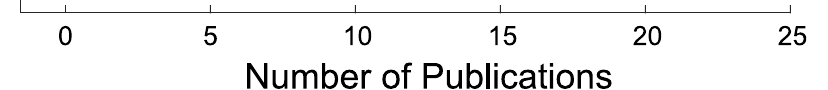
Fig 4. Footwear feature importance and the number of related publications. Footwear feature importance as rated by experts in this study in comparison to the number of available publications for each footwear feature based on a recent literature review (with permission from [13]). The footwear features inside the box represent opportunities for future footwear research: while these features were deemed important by footwear experts, only few publications exist regarding how these features affect runners from different